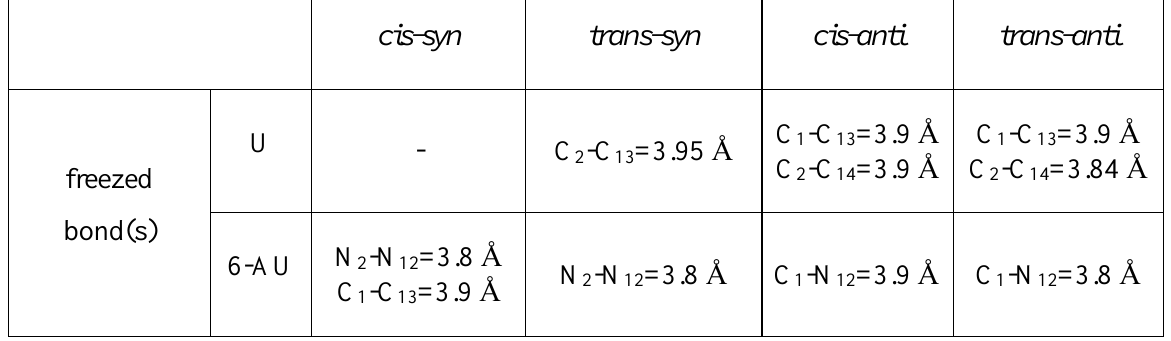
Table S1. Freezed distances in dimers during the CASSCF optimizations